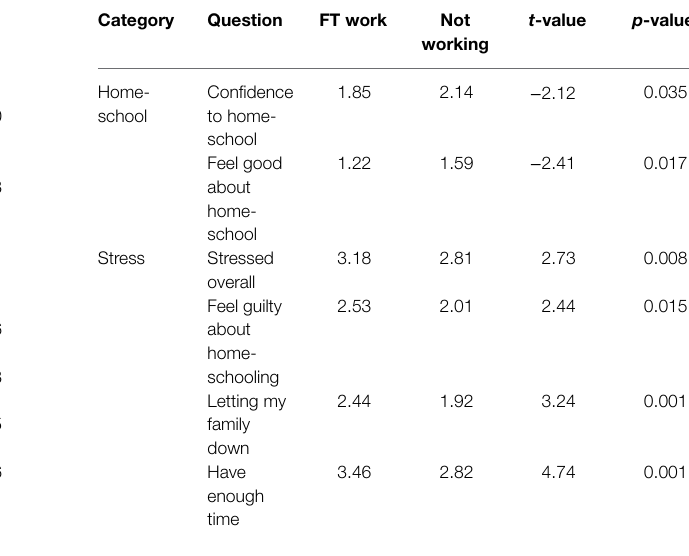
TABLE 2 | Means for the different family sizes for each question with significance levels of the one-way